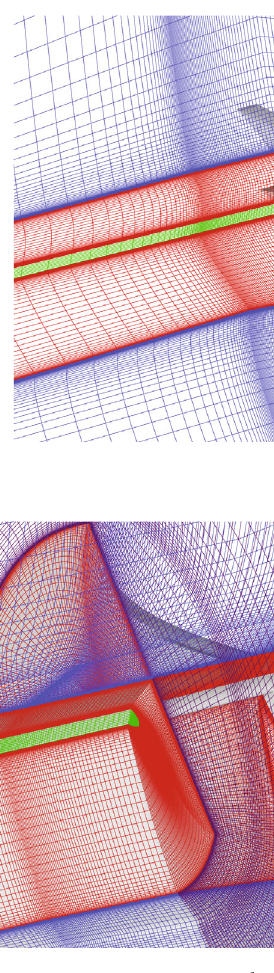
Figure 5: Pregenerated grid at θ = 45 ° . Figure 6: Pregenerated grid at θ = 90 °